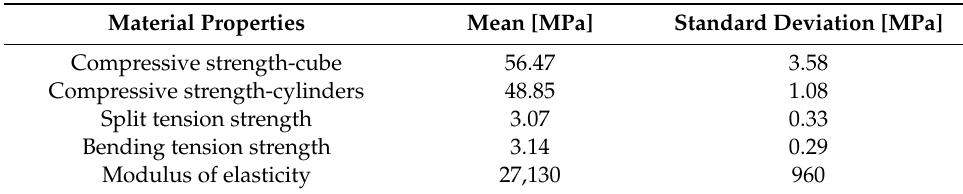
Table 4. Material properties of basic tests.